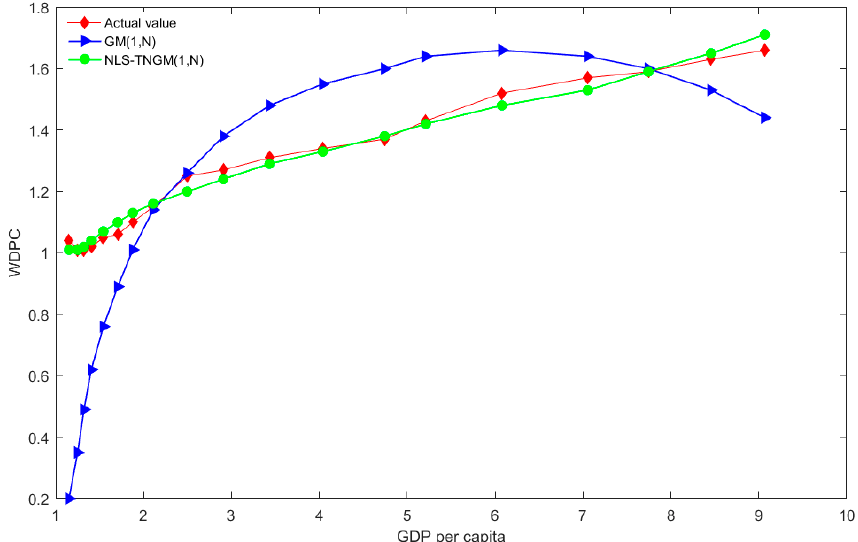
Figure 2. The distributions of forecasted WDPC values using the two models, and actual values. Int. J. Environ. Res. Public Health 2018 , 15 , x